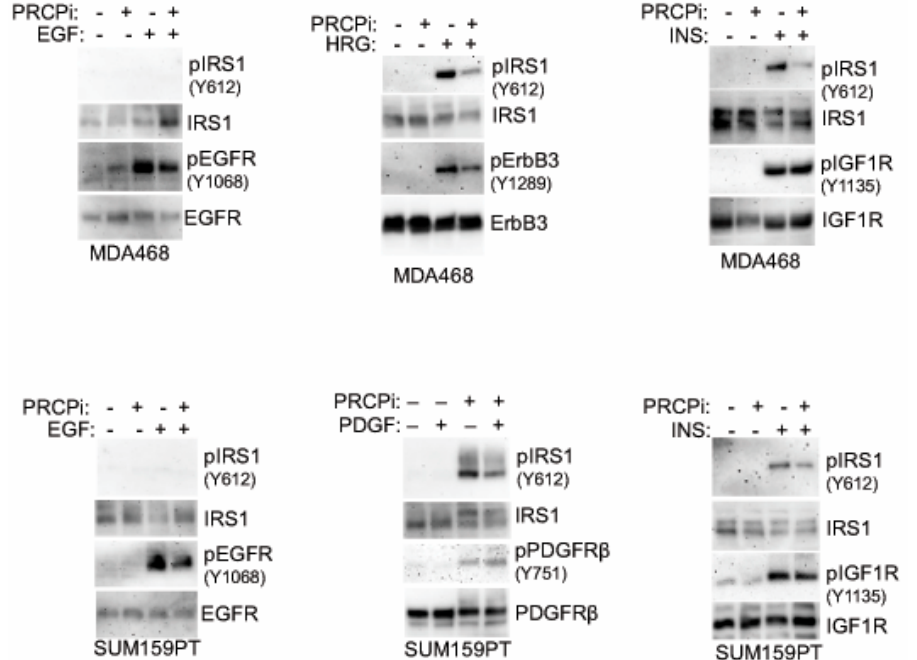
Figure 6. PRCPi decreases tyrosine phosphorylation of RTKs and IRS1. MDA468 cells (top panel) and SUM159PT cells (bottom panel) were serum-starved overnight and then treated with EGF (50 ng/mL), Heregulin b1 (HRG, 50 ng/mL), insulin (INS, 50 ng/mL), or PDGF-BB (50 ng/mL) for 10 min. Lysates were immunoblotted. Original Western Blots and densitometry can be found at Figures S10 and S11.